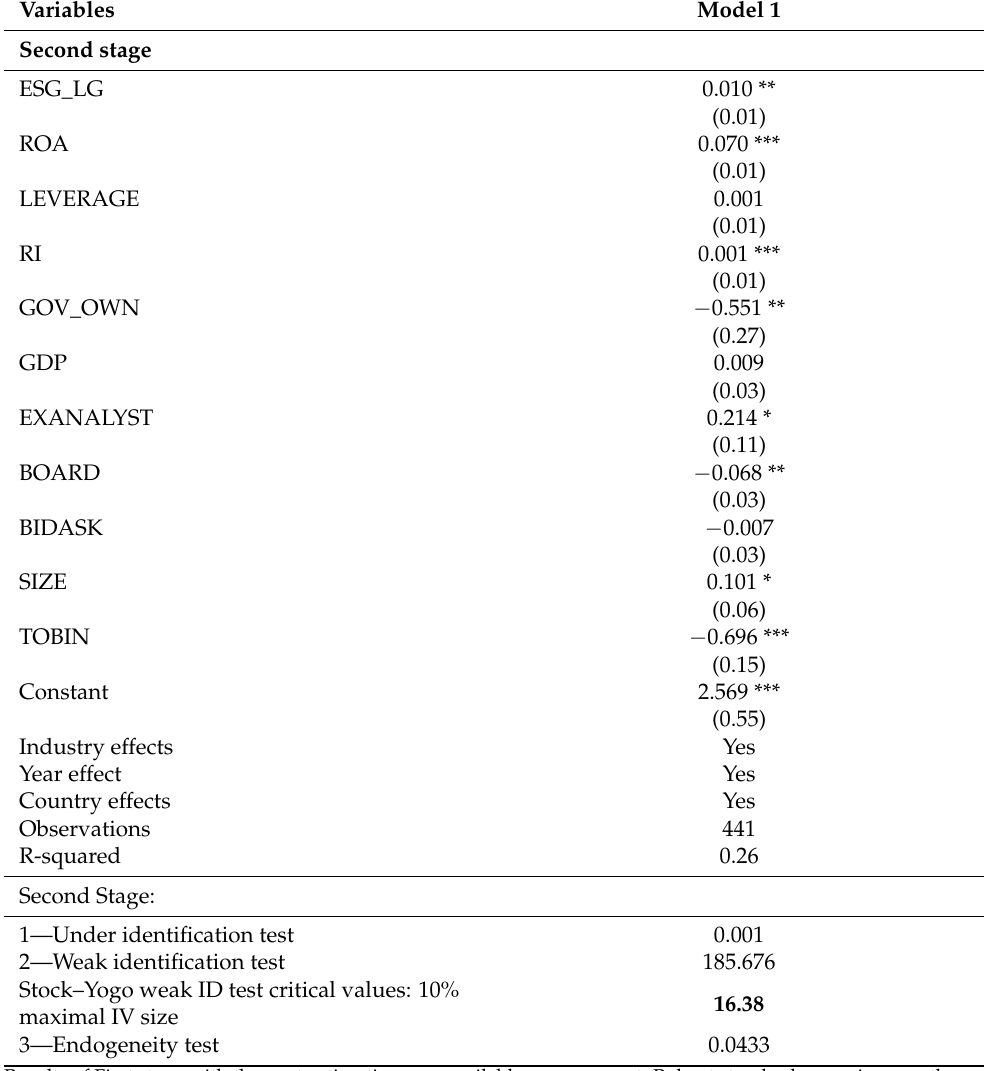
Table 8. Endogeneity check using Two Stage Least Square Equation